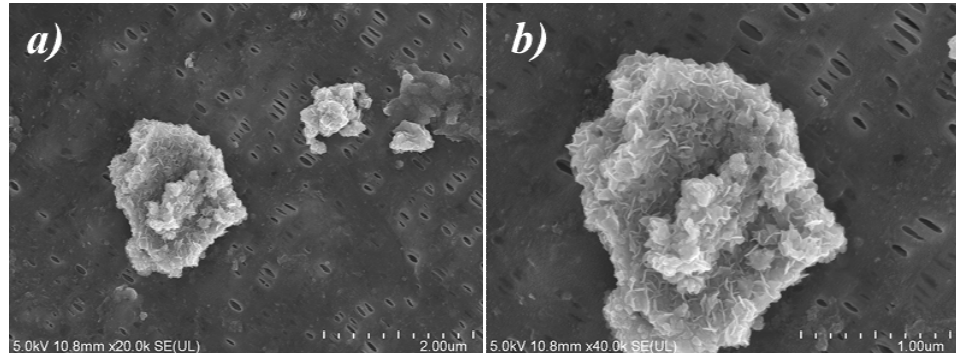
Figure 6. SEM images of MXene / PP separator after cycling: ( a ) 20,000 × and ( b ) 40,000 × .